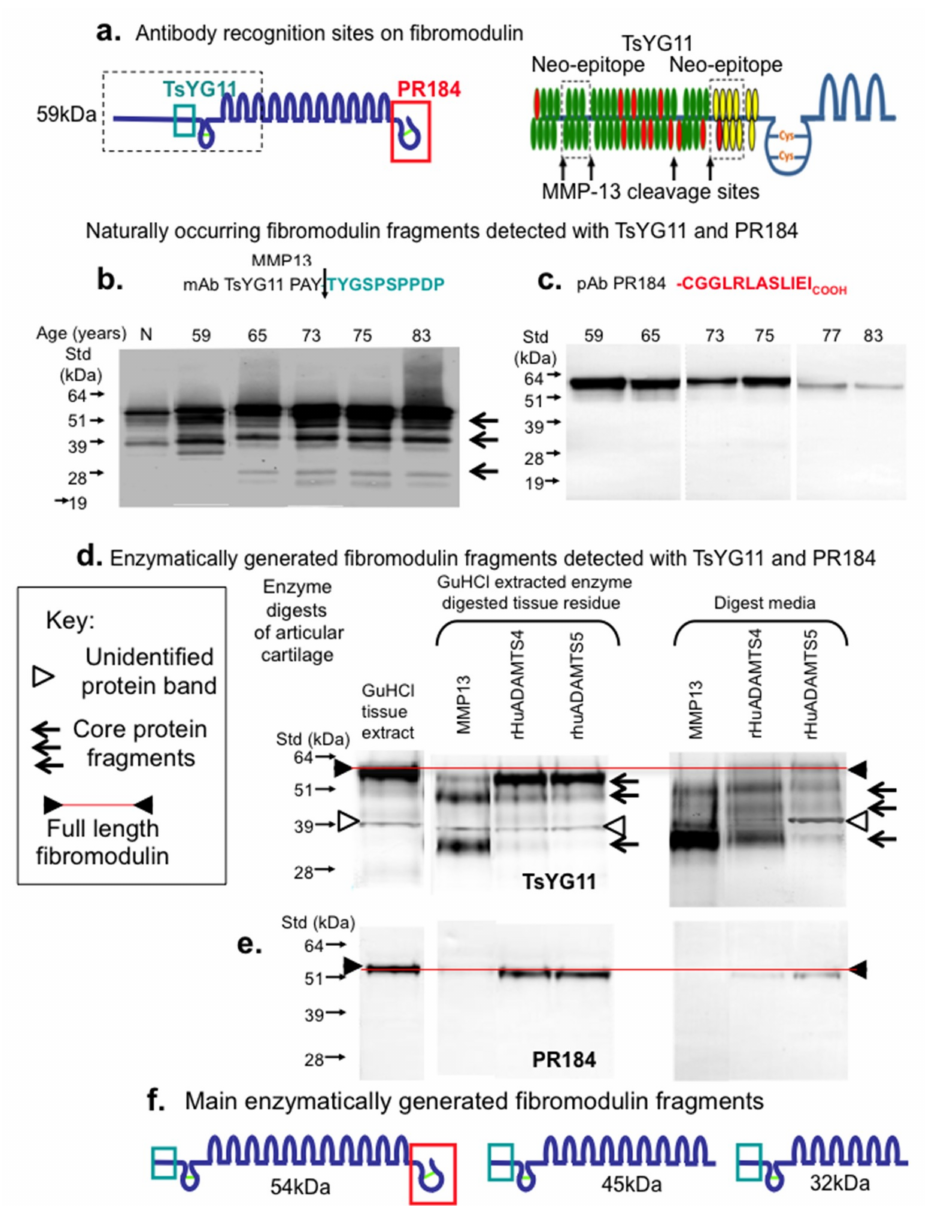
Figure 3. Schematic depiction of the epitopes identified by pAbs TsYG11 and PR-184 ( a ) and identification of naturally occurring FMOD fragments in OA knee cartilage from total knee replacement donors aged 59, 65, 75, 77 and 83 years of age using Western blotting and pAbs TsYG11 ( b ) and PR-184 ( c ) and FMOD species generated in vitro by enzymatic digestion using MMP-13, ADAMTS-4 and ADAMTS-5 detected using pAb TsYG11 ( d ) and pAb PR-184. Schematic depiction of the three major in vitro generated FMOD fragments. ( b – e ) were repeated three times and similar results were obtained. Schematic ( f ) depicts FMOD fragments